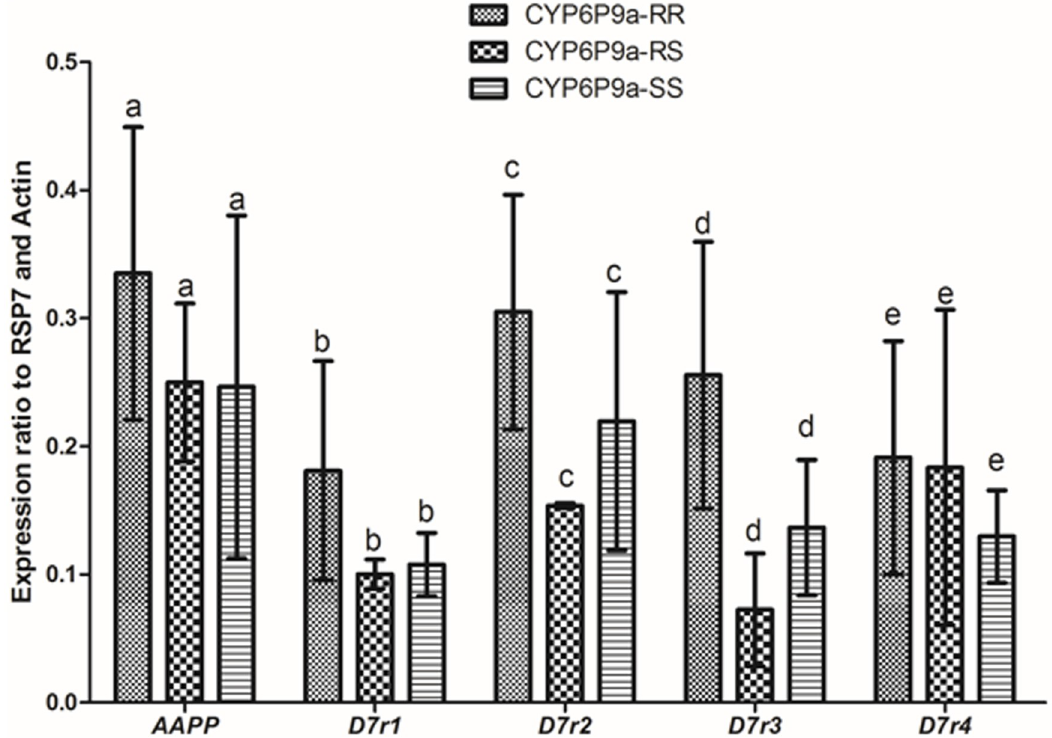
Fig 4. Comparative expression of salivary genes between CYP6P9a genotypes. Expression level of AAPP and some members of D7 family genes in CYP6P9a-RR and CYP6P9a-RS mosquitoes in comparison with CYP6P9a susceptible mosquitoes. The normalized relative expression of each gene against two housekeeping genes (RSP7 and Actin) is represented on the vertical axis. Letters a, b, c, d, e indicates the absence of significant difference in the expression level of each gene between the three types of